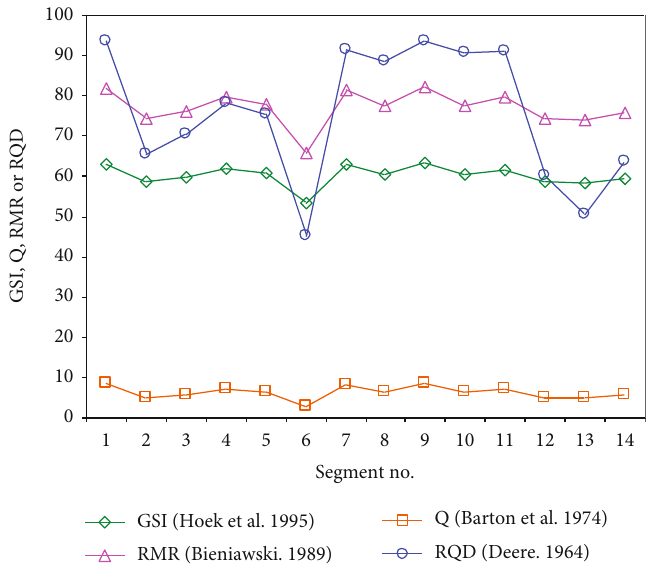
Figure 5: The rock mass classi fi cation for 14 segments passing rock formations using 4 systems: RMR, Q, RQD, and GSI.